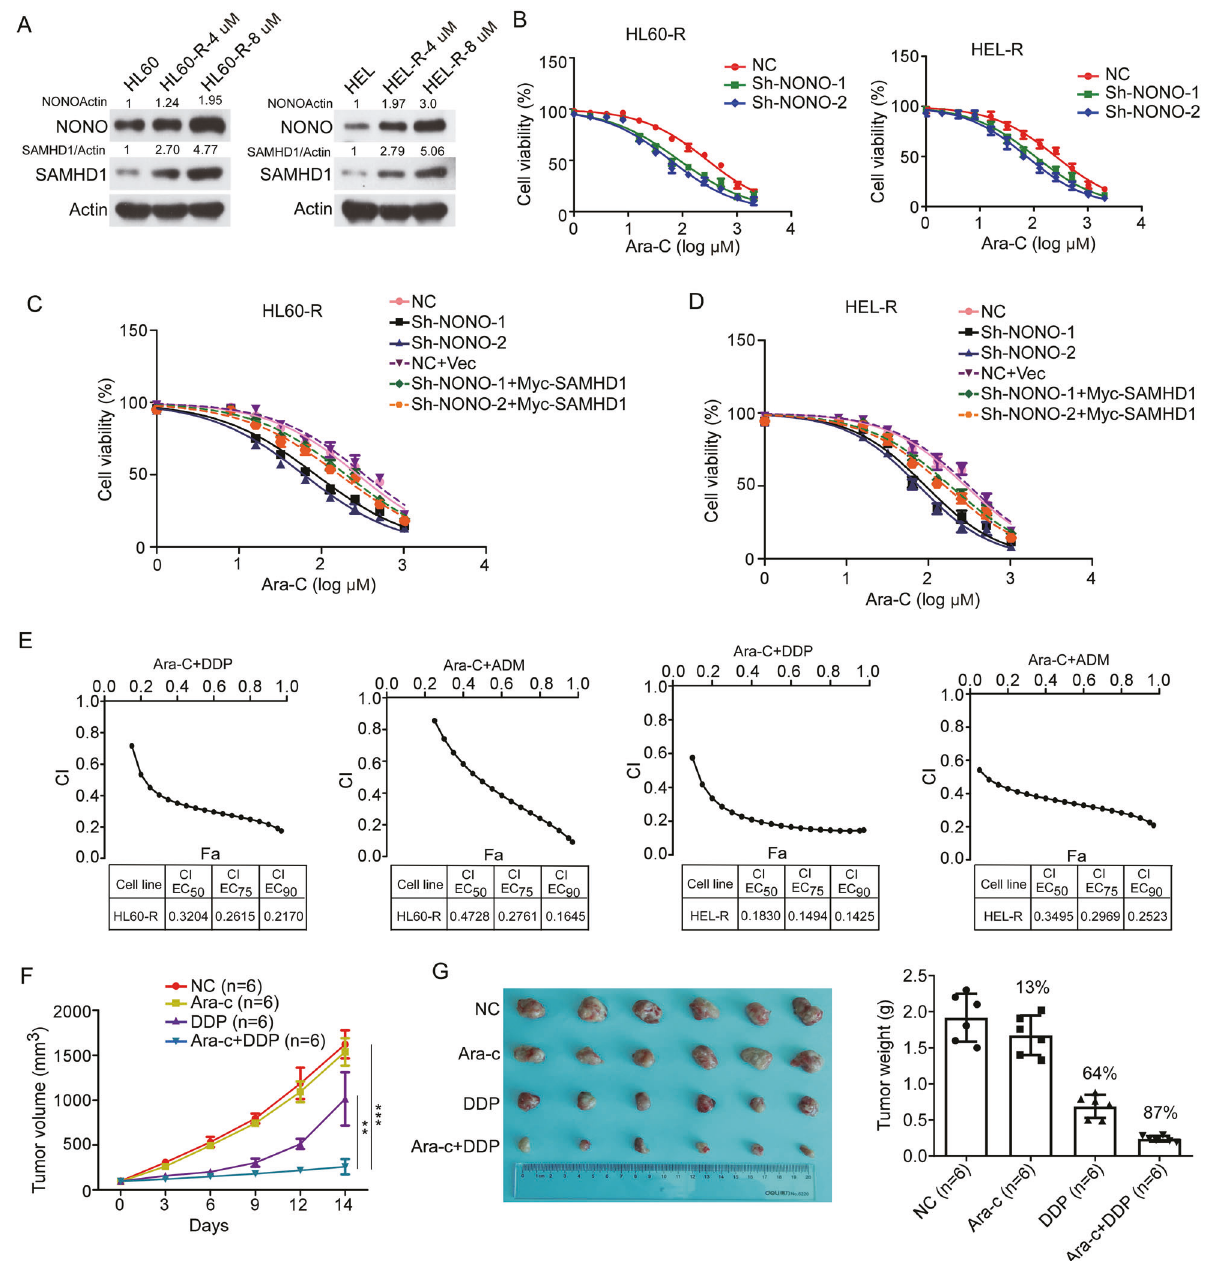
Fig. 7 NONO is crucial for the resistance of AML cells to Ara-C. A Both NONO and SAMHD1 were upregulated in AML-resistant cells compared with the corresponding parental cells. The protein levels of NONO and SAMHD1 in HL60-R and HEL-R cells and the corresponding parental cells were evaluated by western blotting (P indicates parental cells. HL60-R-4 μ M and HL60-R-8 μ M, HEL-R-4 μ M, and HEL-R-8 μ M indicate the maximum sustained concentrations of Ara-C used for culture of the resistant AML cell lines). B Silencing NONO restored the sensitivity of resistant AML cells to Ara-C. Resistant AML cells with or without stable NONO silencing were treated with Ara-C at a series of concentrations as indicated for 48 h, and cell viability was evaluated by a CCK-8 assay ( n = 3, mean ± SD). C , D HL60-R ( C ) and HEL-R ( D ) cells with or without stably silencing NONO were transfected with SAMHD1 or Vector for 24 h. Then the cells were treated with Ara-C at the indicated concentrations for 48 h, and cell viability was evaluated by CCK-8 assay ( n = 3, mean ± SD). E DDP and ADM sensitized resistant AML cells to Ara-C. Plots of the CIs for Ara-C and DDP or ADM in HL60-R and HEL-R cells, as determined using the Chou – Talalay method ( n = 3). F NOD/SCID mice bearing HL60-R cell xenografts were treated with PBS, Ara-C, DDP, or a combination of Ara-C and DDP, and tumor growth was monitored. n = 6 for each group. G The tumor weights for each group as indicated in Fig. 7F. In B-D, 2-way ANOVA was used to compare the behavior of the cells treated as indicated and negative control cells. F , G , a two-tailed unpaired Student ’ s t test was used to determine statistical signi fi cance (** P < 0.01, *** P < 0.001). For respective immunoblots, the protein levels were quanti fi ed by ImageJ The SAMHD1 expression level has been reported to be correlated stabilization of SAMHD1 by NONO is mediated through the with the sensitivity of AML cells to Ara-C [9]. Rudd et al. reported that blockade of ubiquitination/degradation by DCAF1. Indeed, the ribonucleotide reductase inhibitors gemcitabine and hydro- overexpression of NONO attenuated both the interaction of xyurea suppress the Ara-CTPase activity of SAMHD1 and overcome SAMHD1 with DCAF1 and its ubiquitination by DCAF1.